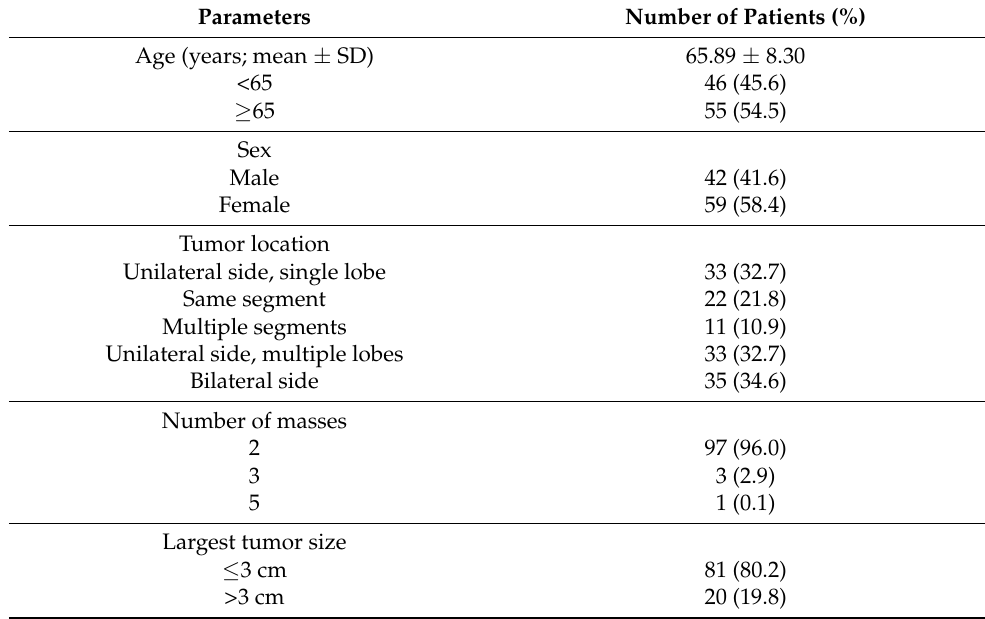
Table 1. Demographic characteristics of